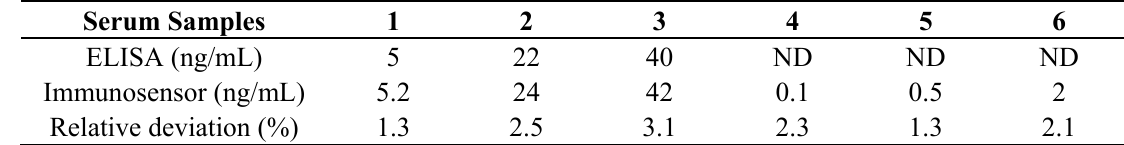
Table 2. Experimental results comparison of two methods obtained in serum samples ( n =